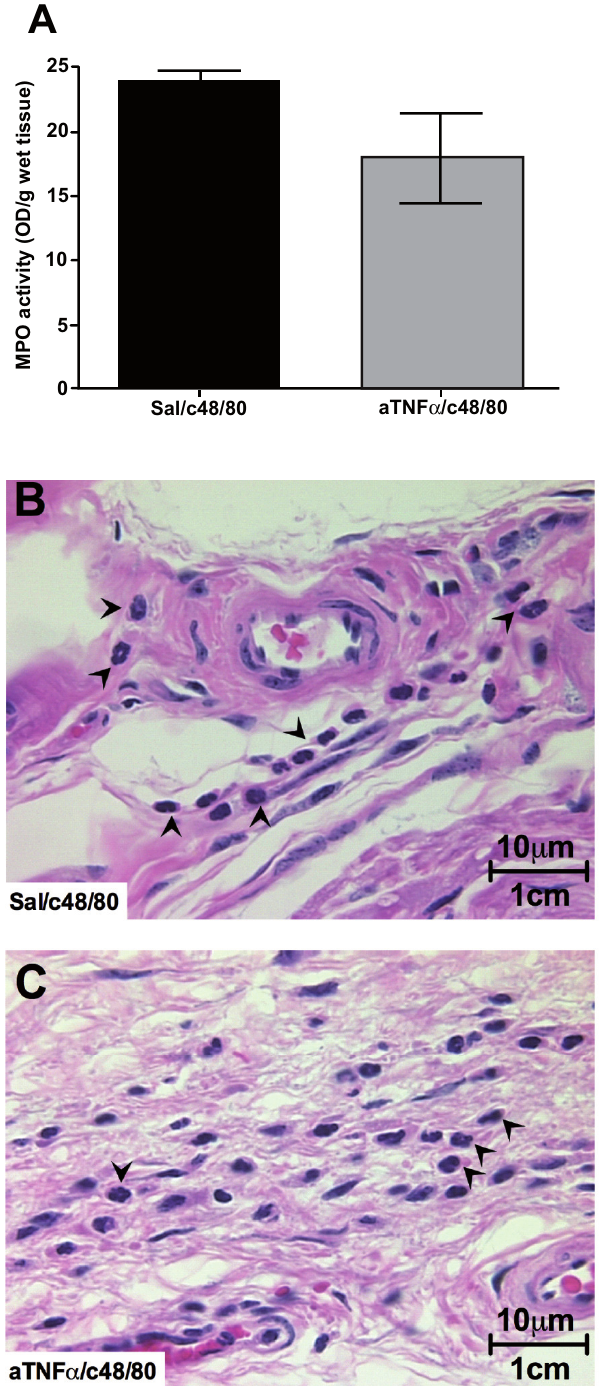
Figure 4. Pre-treatment with anti-TNF- α does not prevent c48/80-provoked neutrophil influx. Mice that received c48/80 intra-plantar injections following anti-TNF- α pretreatment did not have significantly different levels of myeloperoxidase enzyme activity compared to mice that received vehicle pretreatment ( A ). Hind paws were harvested from euthanized mice and assayed for MPO activity; bars represent average MPO activity as OD/g wet tissue and error bars represent ±SEM ( A ). Mice were euthanized 2.5h after c48/80 administration, their hind paws were harvested, preserved in 10% buffered formalin and ethanol, and 4μm paraffin sections stained with hematoxylin & eosin for neutrophil visualization at 1000x. Similar to c48/80-treated mice ( B ), mice pre-treated with anti-TNF- α neutralizing antibody showed clear evidence of neutrophil influx (indicated by black arrowheads) into the affected hind paw tissue ( C ). n = 3 mice per treatment group for MPO assay; data are representative of 2